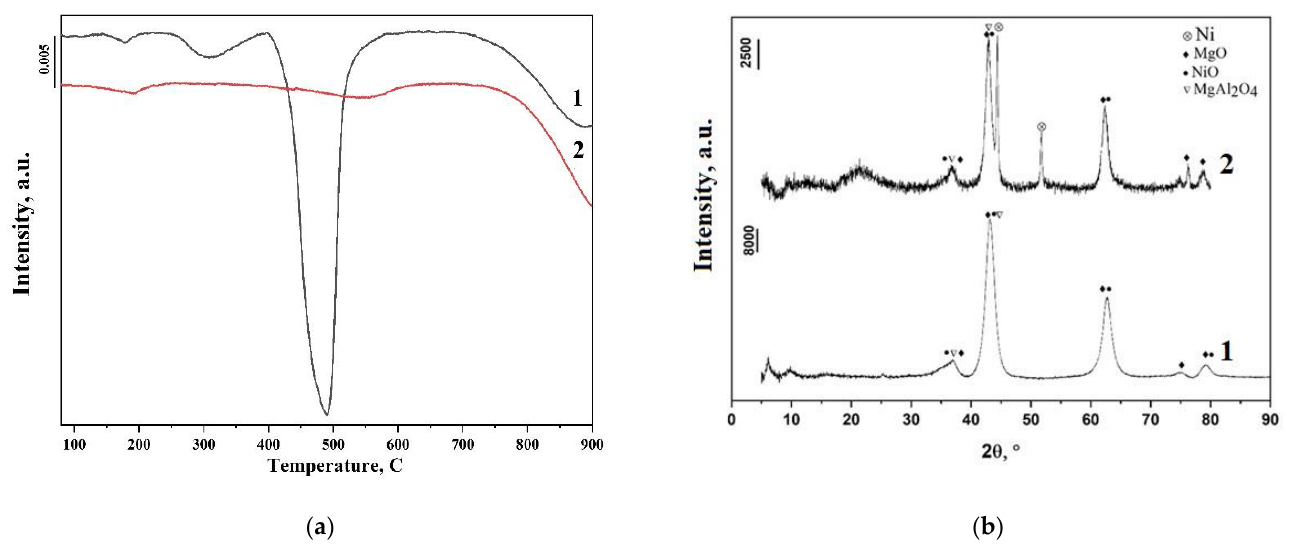
Figure 9. ( a ) H 2 -TPR profiles of 1—Mg/AlNi-25-c, 2—Mg/AlNi25-ox; ( b ) X-ray diffraction patterns for Mg/AlNi-25-c: 1 — original, 2 — reduced.